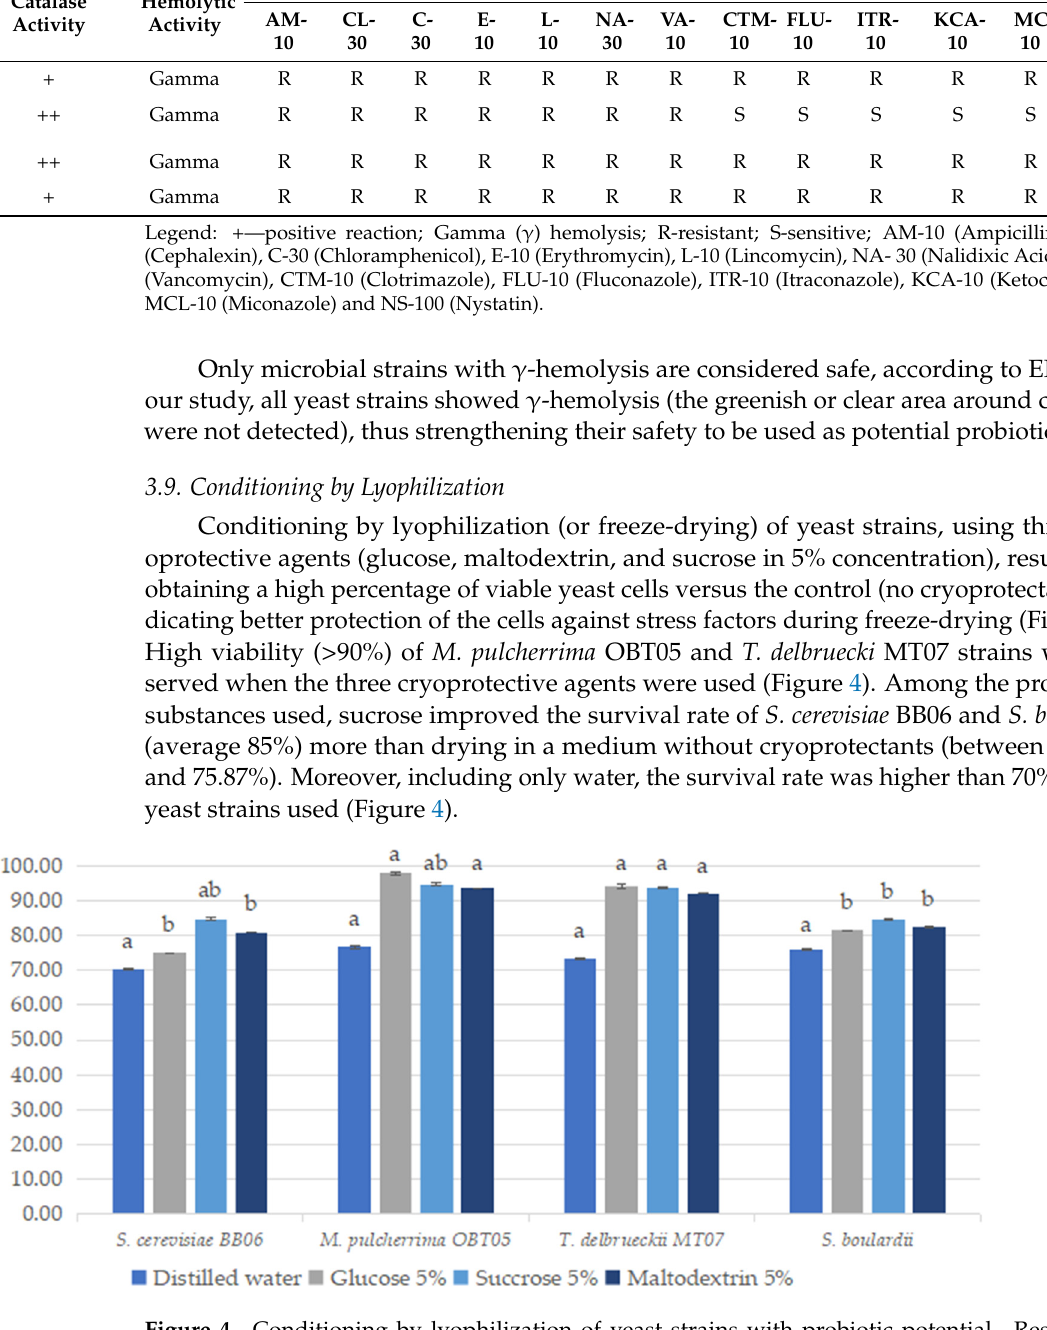
Figure 4. Conditioning by lyophilization of yeast strains with probiotic potential. Results are represented as mean ± SDs of three independent experiments. Significant statistical differences ( p < 0.05) between yeast strains according to the Tukey B test from one-way analysis of variance (ANOVA) have been indicated by different letters.